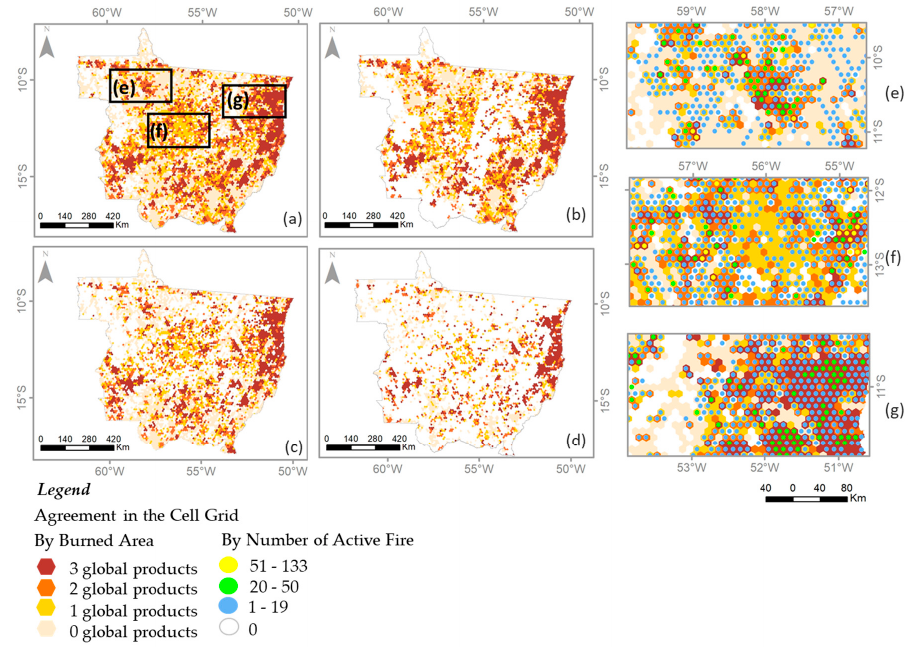
Figure 7. Comparison of results by the proposed approach in the Mato Grosso State with the three global burned area products in terms of an agreement in presence of burned area and final mapped composite ( a ); Landsat-8 OLI ( b ); PROBA-V ( c ); and NPP-VIIRS ( d ). In detail, specific areas are showing active fire spots classified by the number of observations in the cell ( e , f , g ). Blank areas inside the study area represents non-burned area by the classification results.